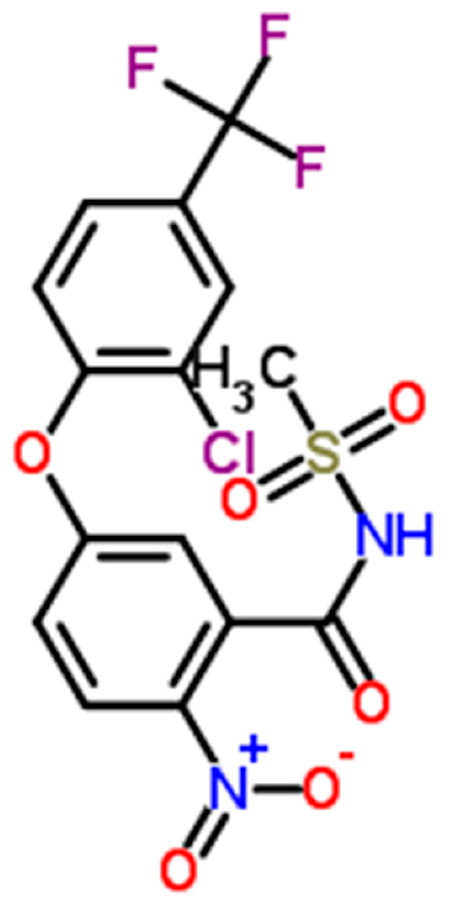
Figure 10. Chemical structure of fomesafen. This molecule has partial charges on the NO 2 group, but is mostly neutral (i.e., with no net electrical charges) at pH < pKa. The N-acyl sulfonamide functional group is ionisable with a pKa = 3.0 [47] .